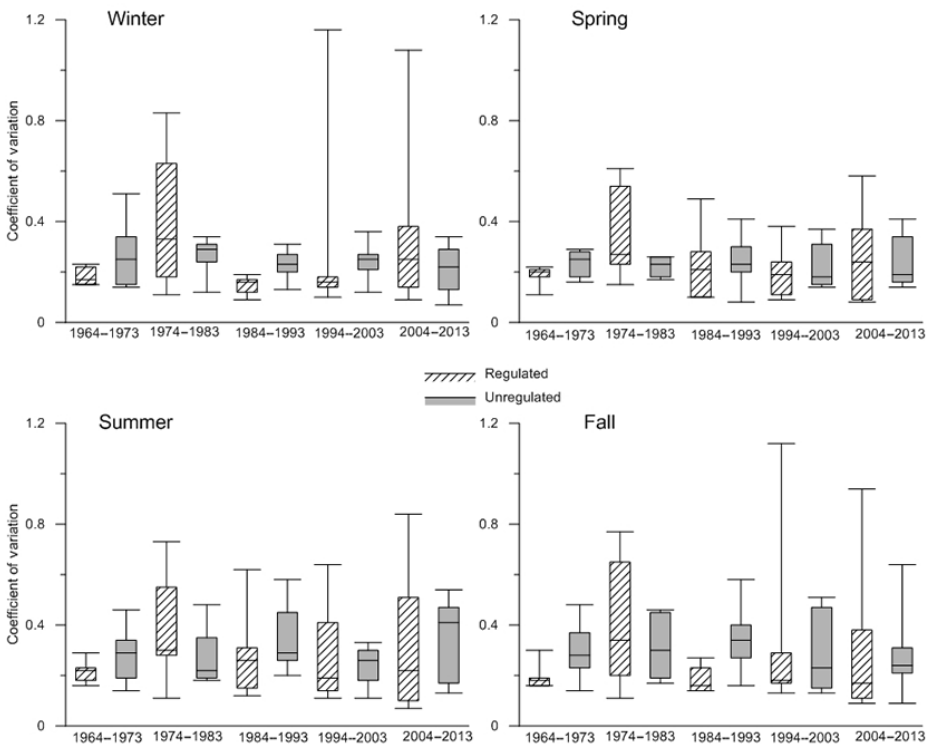
Figure 8. Box-and-whisker plots of the coefficient of variation of seasonal river discharge for eight regulated and seven “matching” unregu- lated rivers for 5 decades over 1964–2013. Boxes indicate the 25th and 75th inter-quantile ranges with the central horizontal lines denoting the median values, while the whiskers represent the 5th and 95th percentiles in the data.